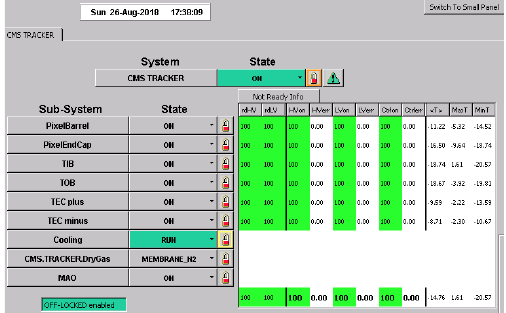
Fig. 3. Tracker FSM top